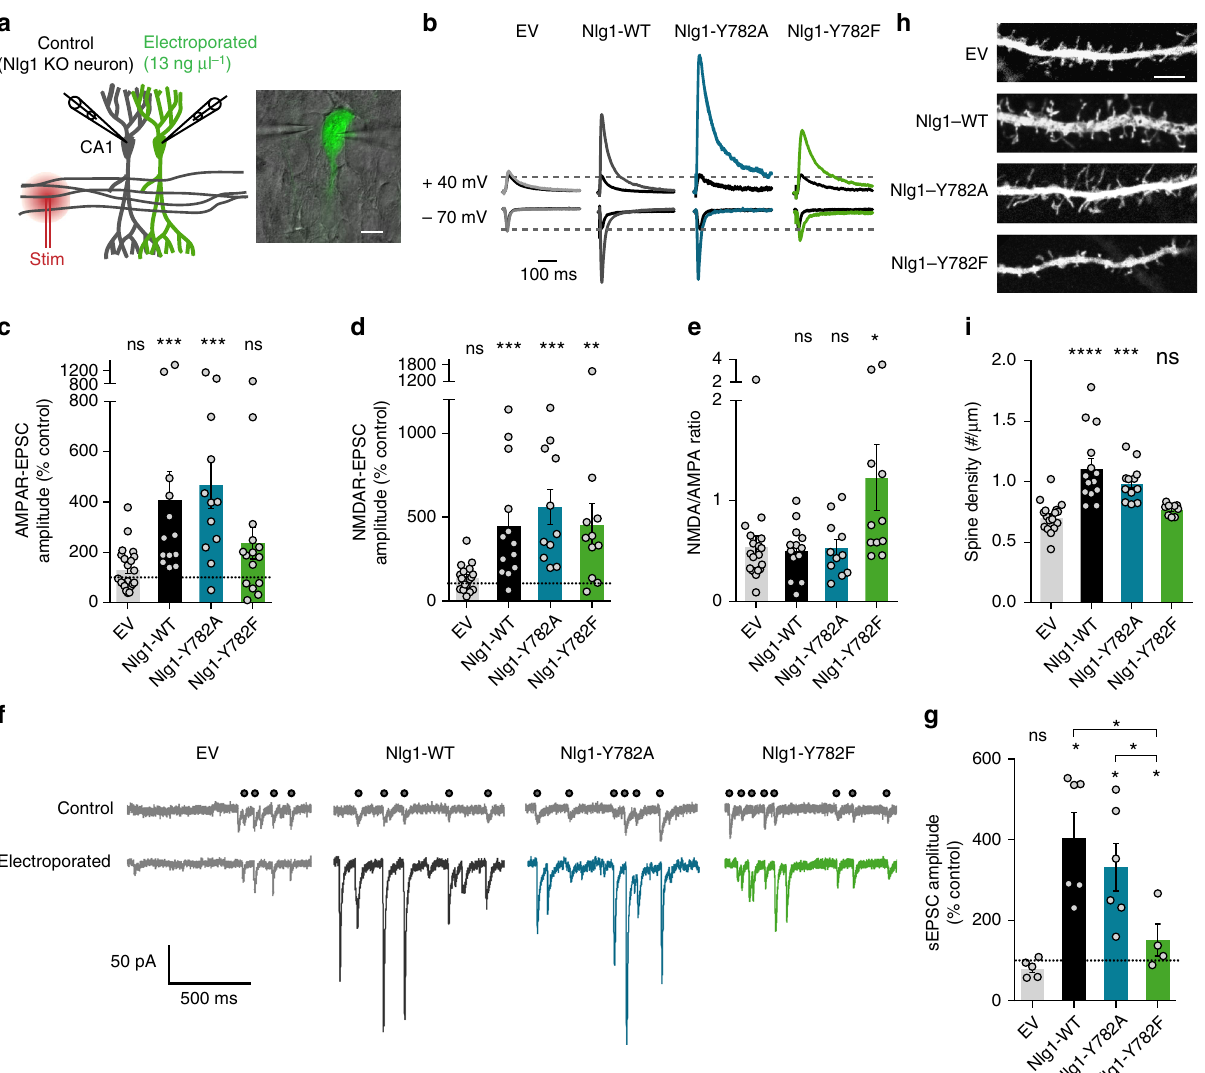
Fig. 4 Nlg1 mutants differently affect excitatory synaptic transmission and spine density. CA1 neurons of organotypic hippocampal slices from Nlg1 KO mice were single-cell electroporated at DIV 3 – 5 with GFP plus EV, Nlg1-WT, Nlg1-Y782A, or Nlg1-Y782F, then processed for electrophysiology or immunostaining and confocal imaging at DIV 13 – 15. a Dual whole-cell recording con fi guration (left) and corresponding image from an experiment (right). Scale bar, 10 µ m. b Representative traces of evoked AMPAR- and NMDAR-mediated EPSCs recorded at − 70 mV and + 40 mV, respectively. Color sample traces correspond to electroporated neurons in the different conditions, and black traces correspond to control, unelectroporated neurons. c , d Average AMPAR- and NMDAR-mediated EPSC amplitudes, respectively, normalized to the control condition (the dashed line indicates 100%, dot plots corresponds to different pairs, from 4 independent experiments). e Average ratio between paired NMDAR- and AMPAR-mediated EPSCs. f Representative traces of spontaneous EPSCs recorded at − 70 mV from electroporated and non-electroporated neurons. Black dots indicate synchronous events. g Average of paired spontaneous EPSC amplitudes recorded in electroporated neurons, normalized to the control condition (dashed line at 100%, dot plots corresponds to different pairs, from 3 independent experiments). h Representative confocal images of secondary apical dendritic segments from CA1 pyramidal neurons co-expressing GFP along with EV, Nlg1-WT, Nlg1-Y782A, or Nlg1-Y782F. Scale bar, 5 µ m. i Average spine density for the same conditions (dot plots corresponds to different cells, from 4 independent experiments). Data from graphs c , d , and g were compared to the control condition (non-electroporated neurons) by a Wilcoxon matched-pairs signed rank test. Data in graph e were compared by a Kruskal – Wallis test followed by Dunn ’ s multiple comparison test. Data in graphs g and i were compared by one-way ANOVA followed by Tukey ’ s multiple comparison test (ns: not signi fi cant, * P < 0.05, ** P < 0.01, *** P < 0.001, **** P < 0.0001). Data represent mean ±